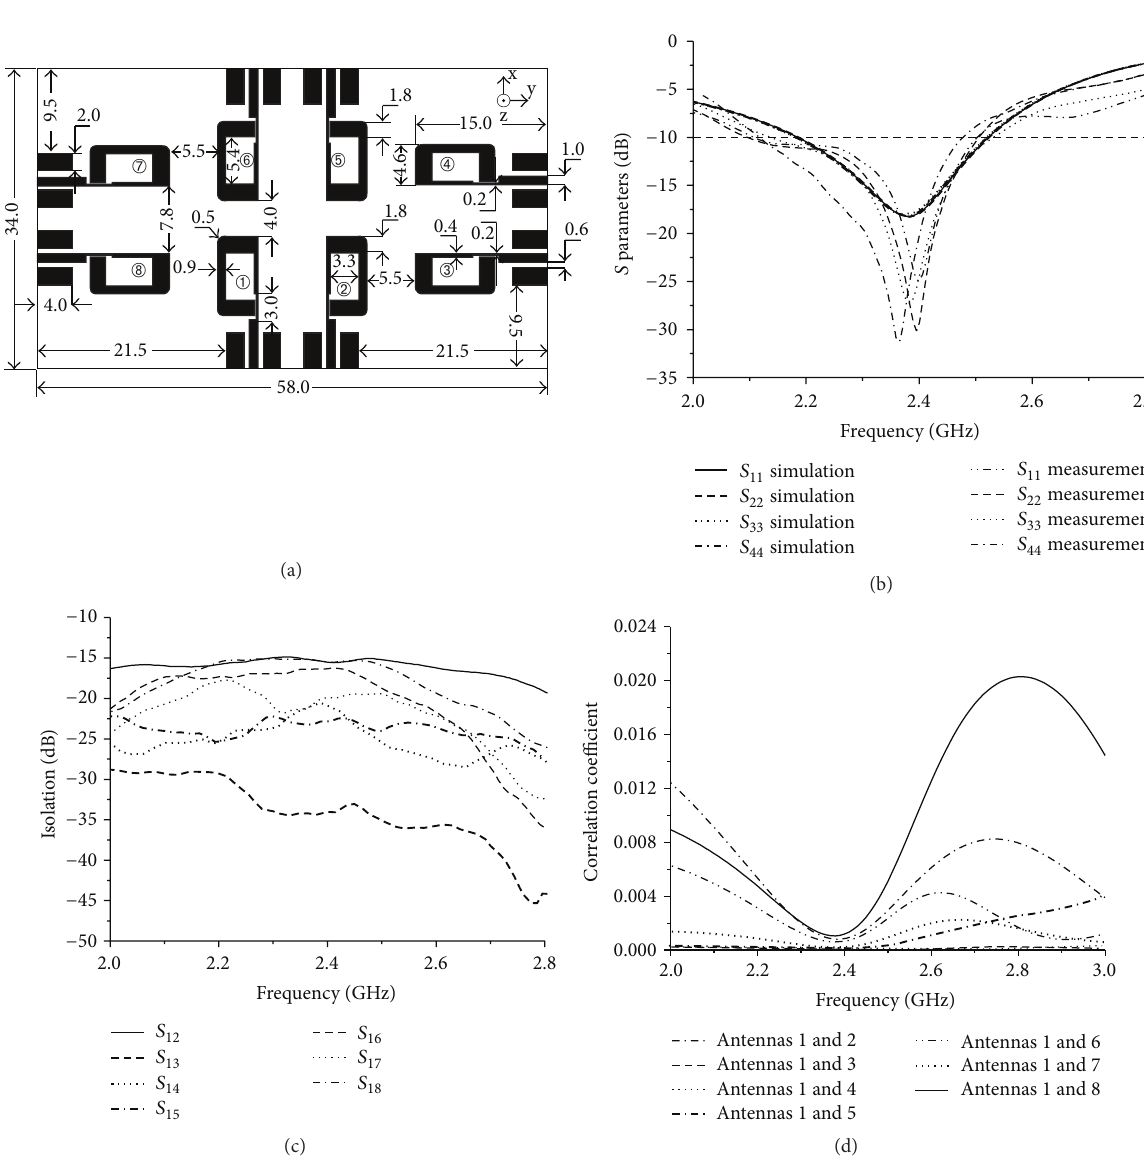
Figure 14: (a) Geometry of the 8-element MIMO antenna system. (b) Reflection coefficients of the MIMO antenna system. (c) Measured isolation between MIMO antenna elements. (d) Correlation coefficient |𝜌| curves for the proposed MIMO antenna